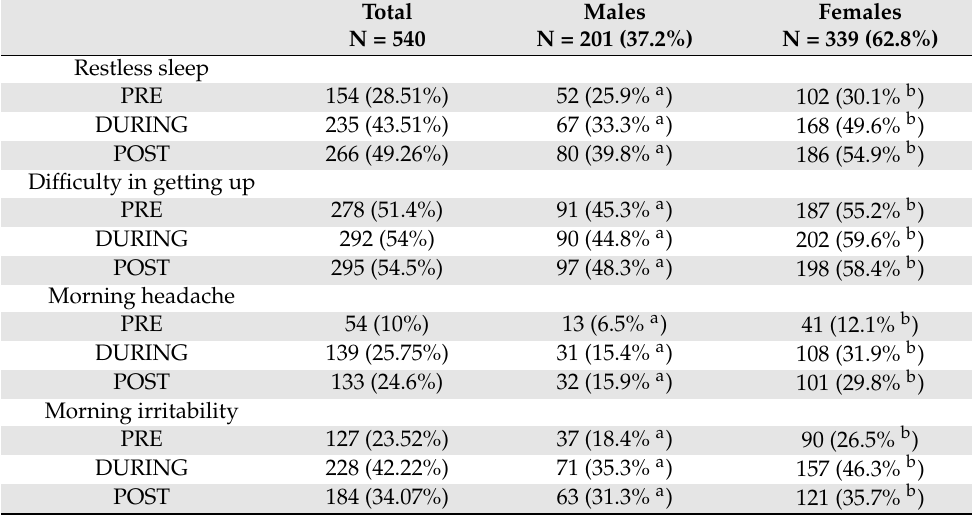
Figure 3. Sleep arrival during quarantine (minutes).